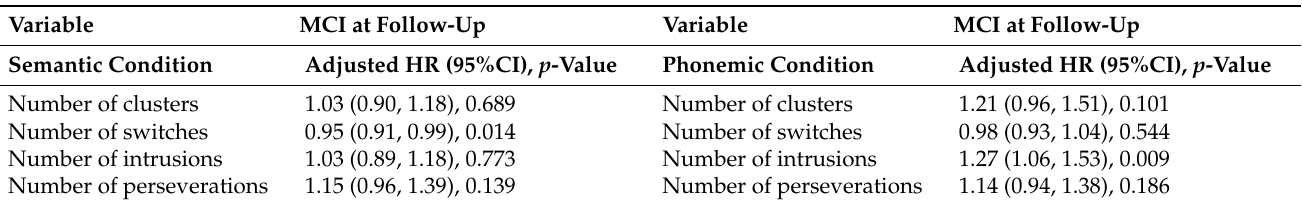
Table 5. Associations between qualitative verbal fluency indices and incident mild cognitive impair- ment